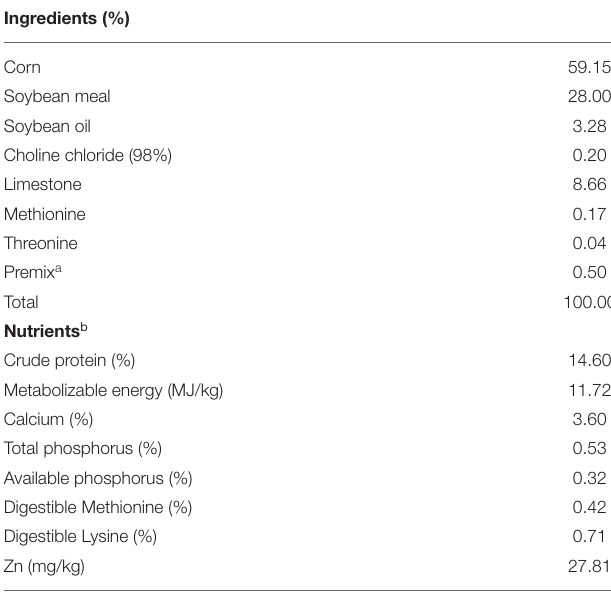
TABLE 1 | Dietary composition and nutrient levels of the basal diet for broiler breeders (air-dried basis). Ingredients